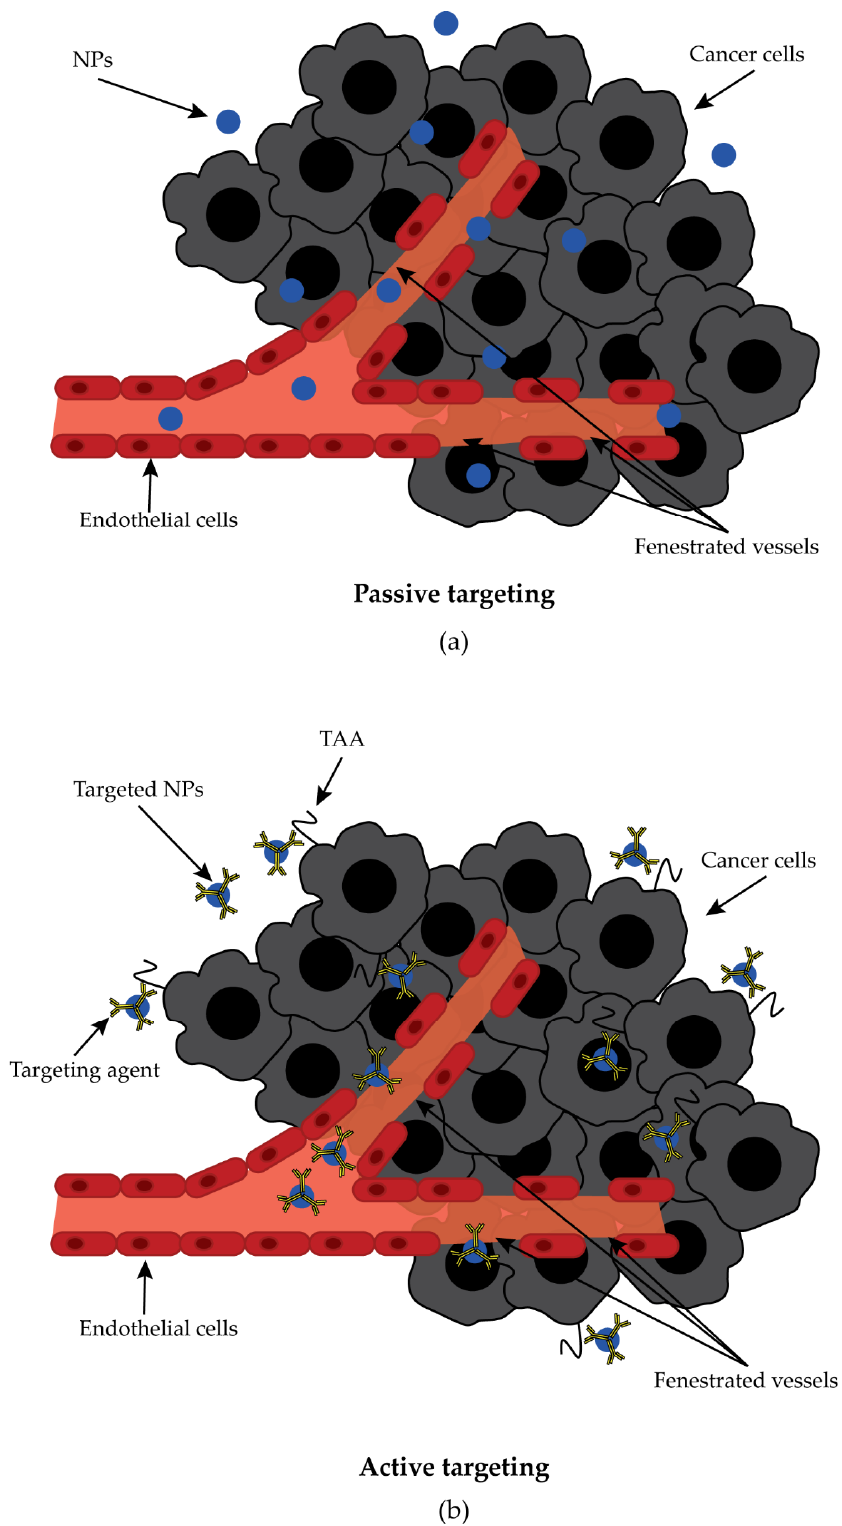
Figure 5. Panel ( a ): Passive targeting. NPs extravasate from blood circulation through the fen- estrated vessels present in the leaky vasculature of a tumor, taking advantage of the EPR effect. Panel ( b ): Active targeting. NPs reach the tumor site through EPR and interact with the TAA through the targeting agent bound on the NPs